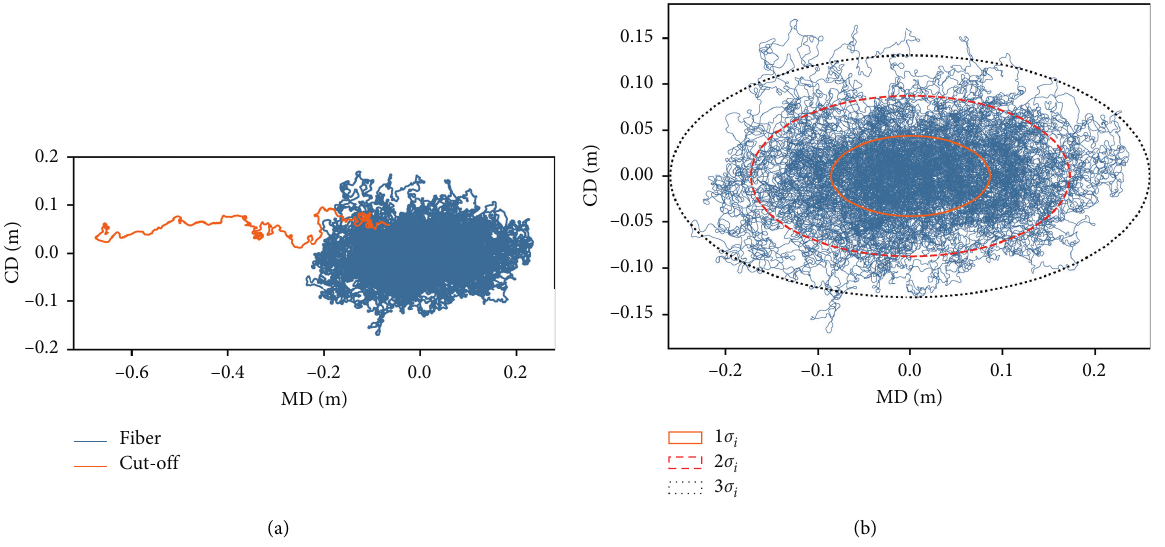
Figure 6: (a) Backtracked fiber laydown with tail (orange) caused by process initialization, (b) standard deviations of throwing range for laydown with tail cut